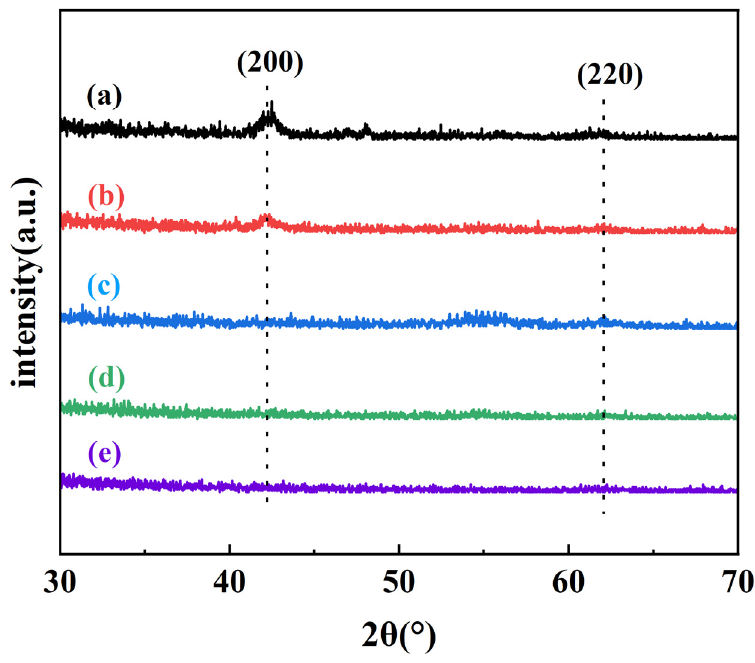
Figure 7. XRD patterns of 100 nm thin film: ( a ) MgO, ( b ) 1:1 Al 2 O 3 :MgO layer alternation type, ( c ) 2:1 Al 2 O 3 :MgO layer alternation type, ( d ) 3:2 Al 2 O 3 :MgO layer alternation type, and ( e ) 5:4 Al 2 O 3 :MgO layer alternation type.